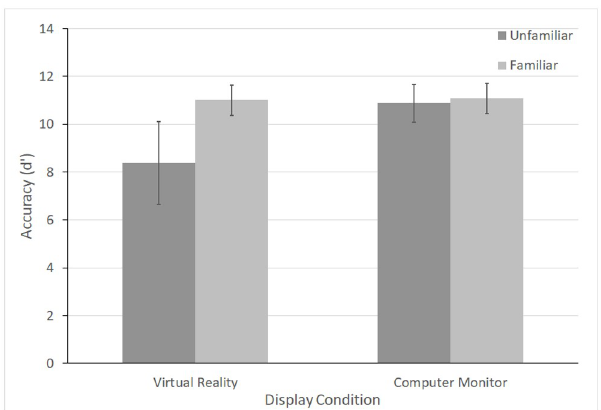
Fig 3. Accuracy for type 2 questions. d’ is plotted for each Familiarity by Display condition. Larger d’ values indicate that pairs were better able to select relevant information while simultaneously ignoring distracting information. Error bars represent standard error of the mean. In VR, familiar pairs performed better than unfamiliar